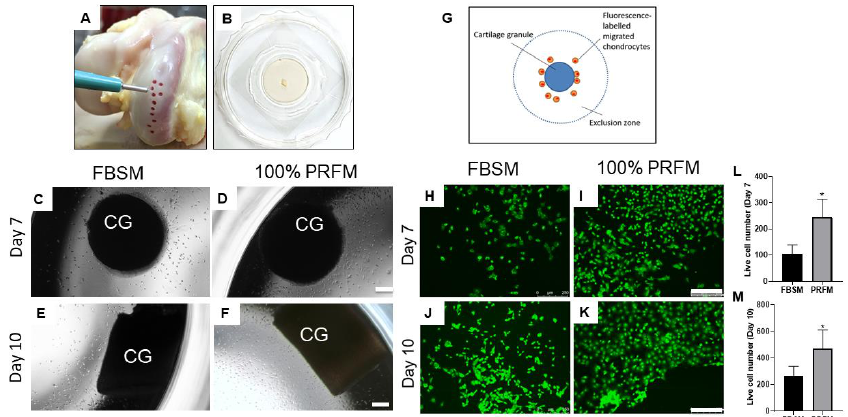
Figure 2. Chemotactic effects of platelet-rich fibrin-conditioned medium (PRFM) on